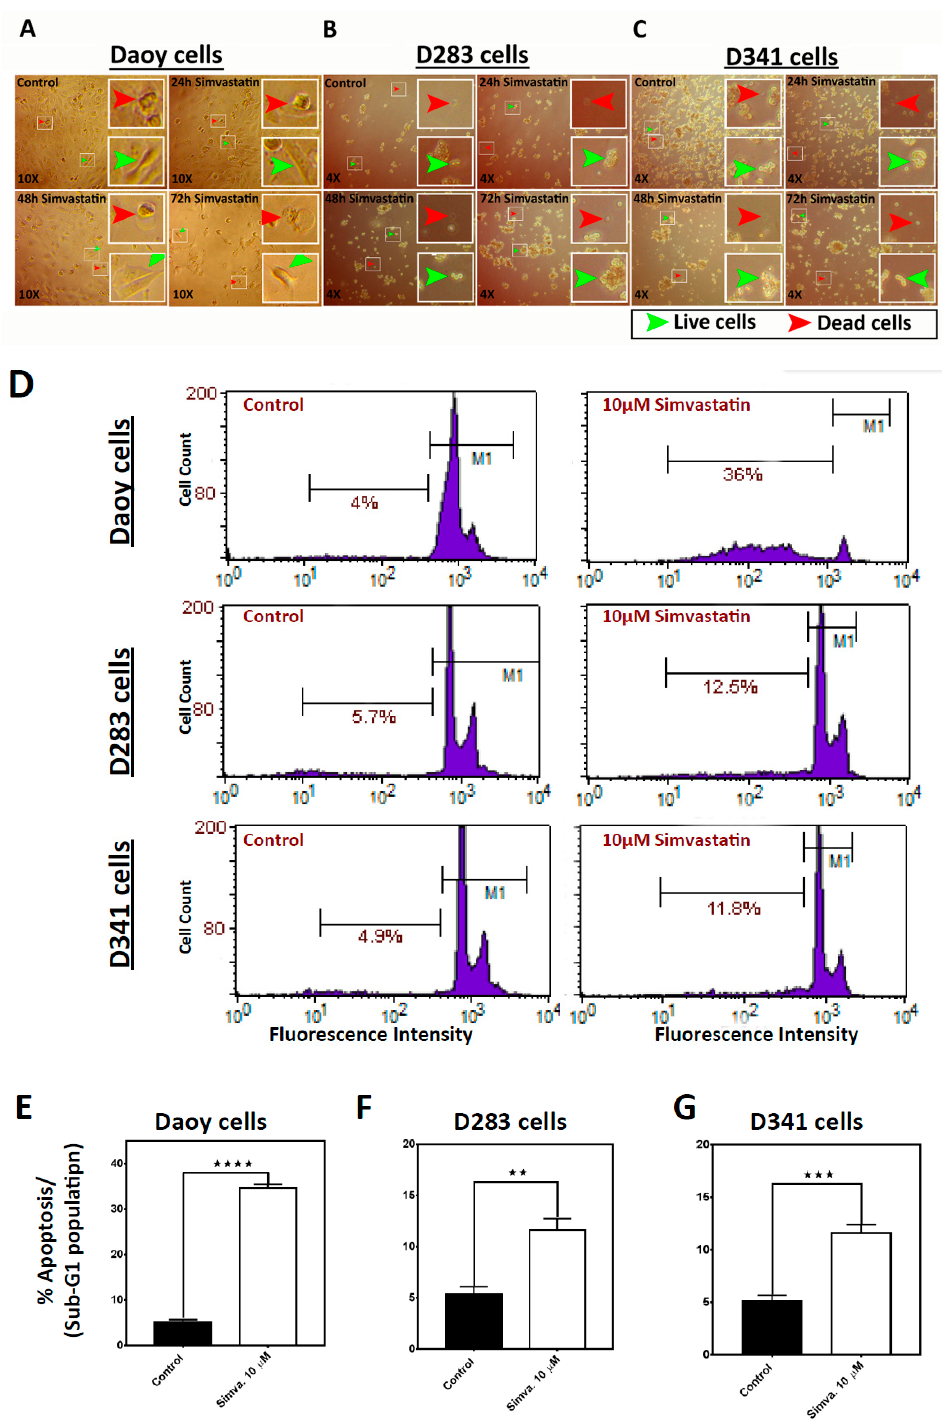
Figure 2. Simvastatin induces apoptosis in medulloblastoma cells. ( A – C ) The morphology of control and treated cells with 10 µ M simvastatin is shown for the Daoy, D283, and D341 cells using a bright field microscope at 72 h. Green arrows indicate examples of live cells, and red arrows indicate examples of dead cells. ( D ) For flow cytometry, control and simvastatin-treated cells (10 µ M) were collected at the 72 h time-point using standard cell collection protocol. Apoptotic cells were detected using Propidium Iodide (PI) Nicoletti flow cytometry and fluorescence-activated cell sorting (FACS) analysis. ( E – G ) Quantification of the sub-G1 population of results from part D, flow cytometry. There is an increased percentage of apoptotic cells in all tested cell lines (E: Daoy, F: D283, and G: D341). Statistical significance is reported by one-way ANOVA using GraphPad Prism 7.0. The p -value is reported as **** p < 0.0001, *** p < 0.001, or ** p < 0.01. Data are expressed as means ± SEM, and with n = 3 ±